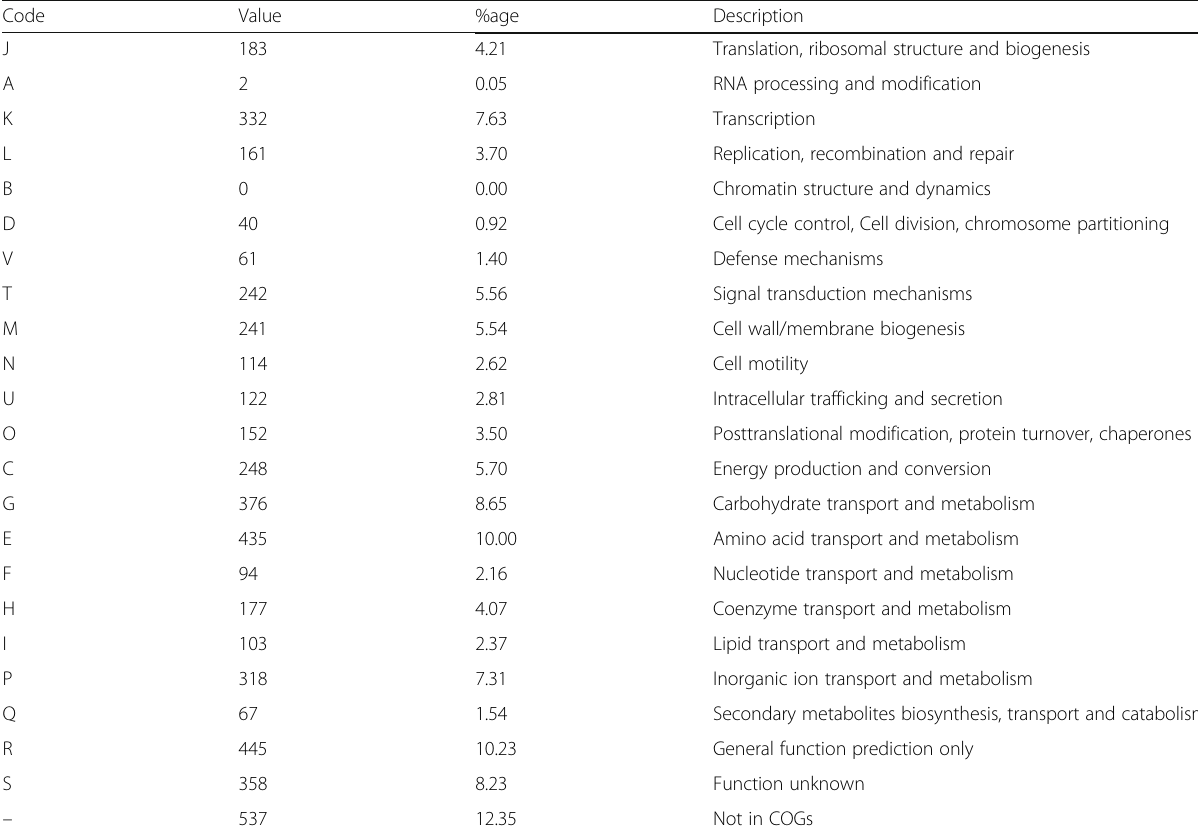
Table 5 Number of genes associated with general COG functional categories